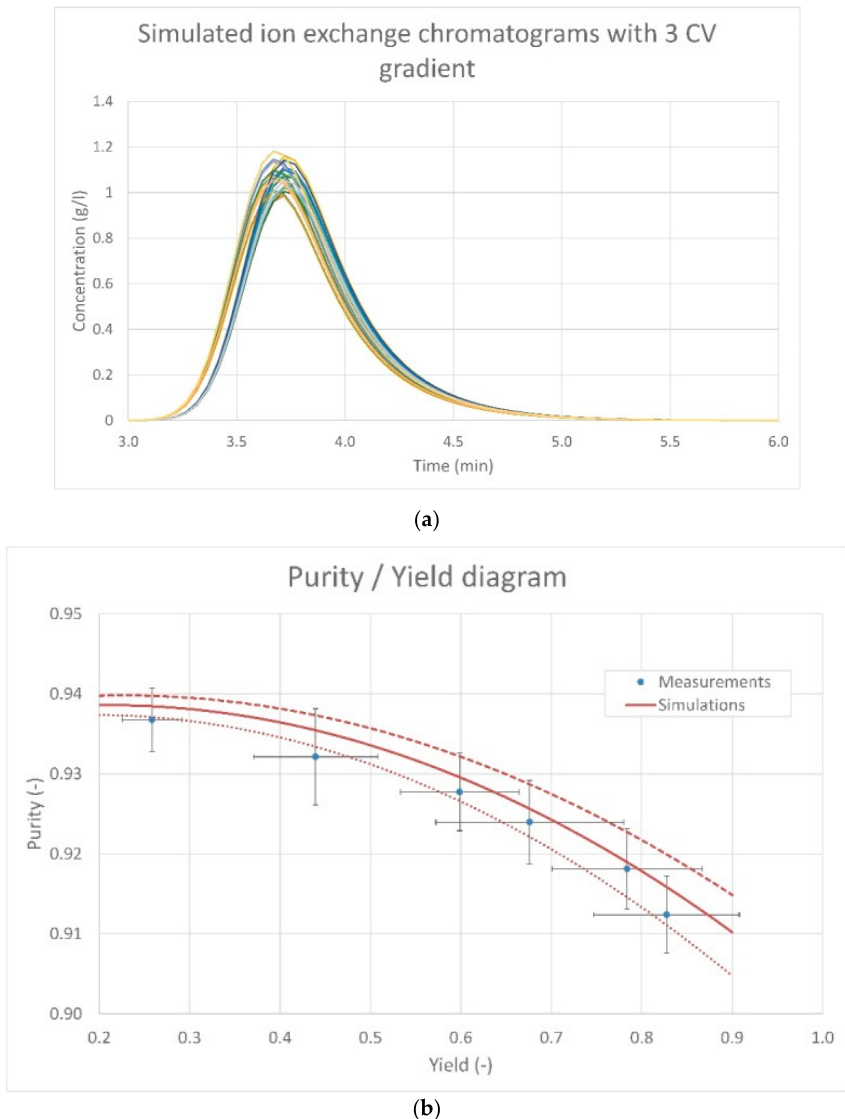
Figure 6. ( a ) All simulated chromatograms that led to the envelope curve in Figure 5 ( b ) Purity-over-yield diagram for the 5 CV separation. Red lines represent simulations; blue dots with error bars represent experiments.